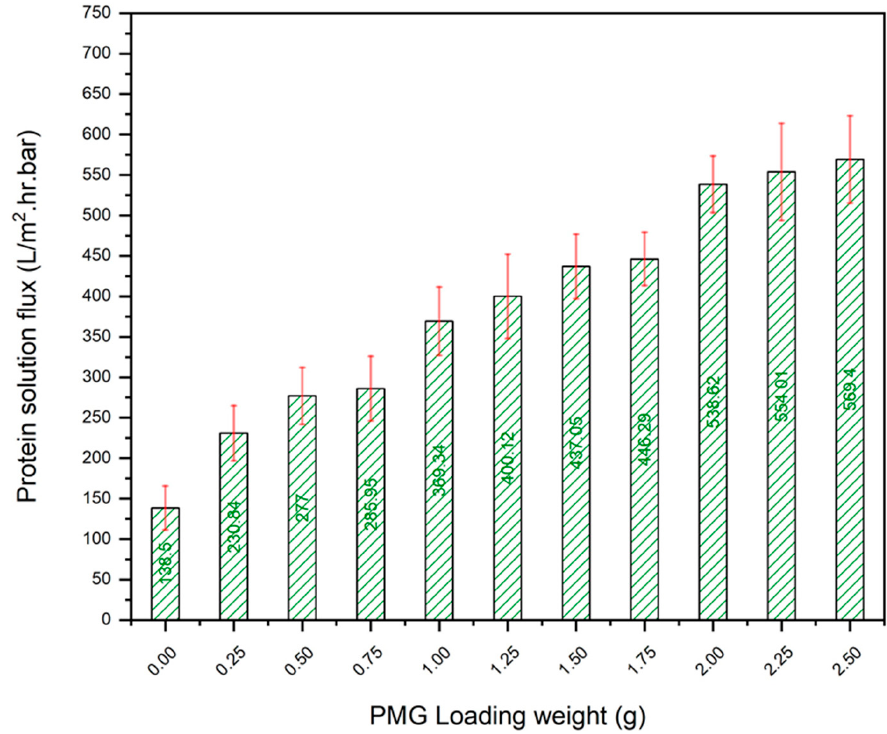
Figure 12. Bovine serum albumin solute flux for PMG-modified nanocomposite membranes.